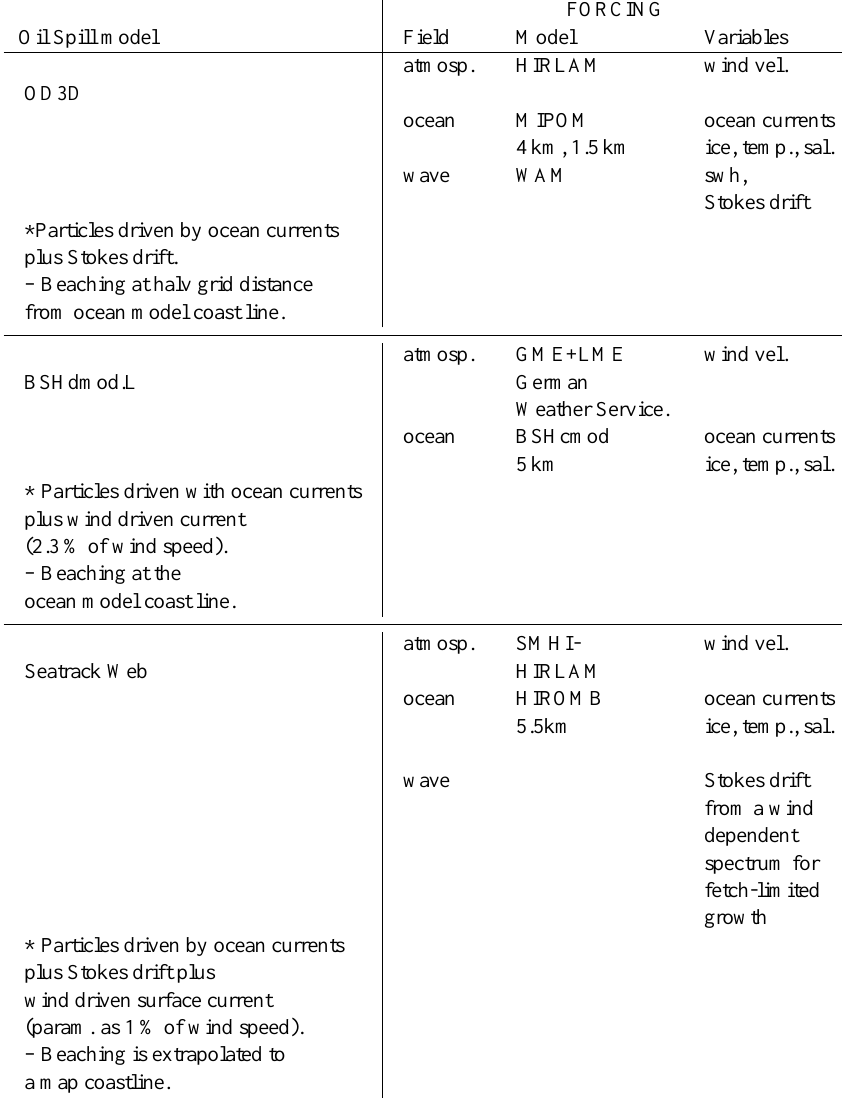
Table 1. Overview of the three different oil drift modeling systems used in this